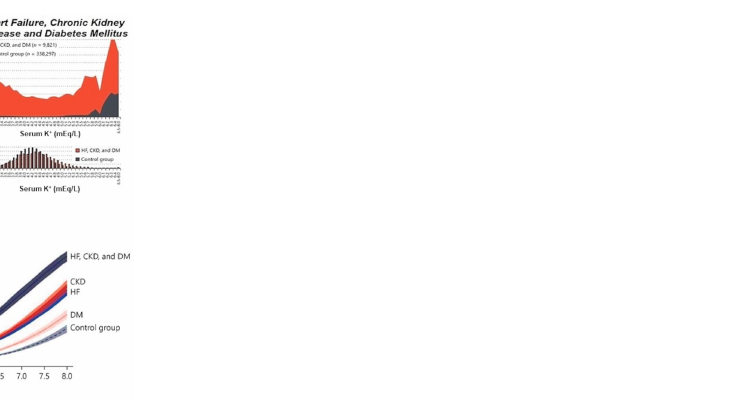
Figure 1. Mortality according to serum potassium concentration in individuals with diabetes mellitus, associated or not with other comorbidities and distribution of serum potassium concentration in these populations. ( A ) Diabetes Mellitus versus Control Group. ( B ) Heart Failure, Chronic Kidney Disease, and Diabetes Mellitus versus Control Group. ( C ) Correlation between serum potassium levels and predicted probability of mortality according to each comorbidity and when comorbidities were combined. CKD: Chronic Kidney Disease; DM: Diabetes Mellitus; HF: Heart Failure. Adapted from